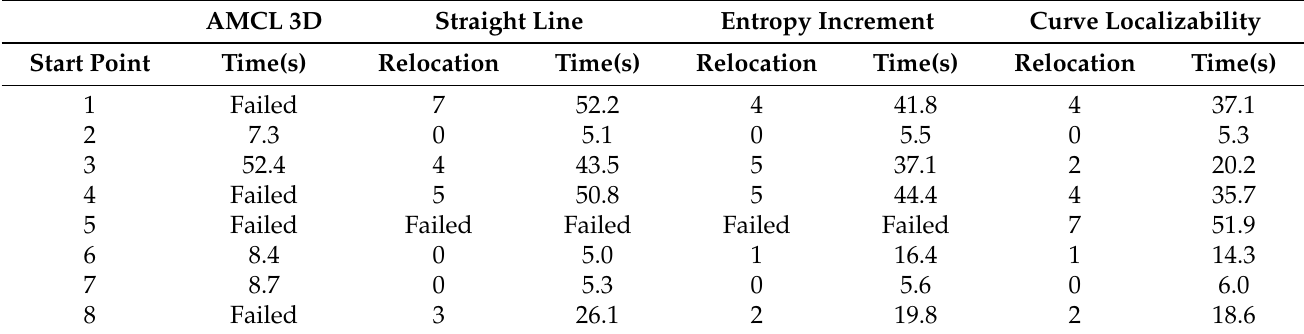
Table 2. Global localization results of different